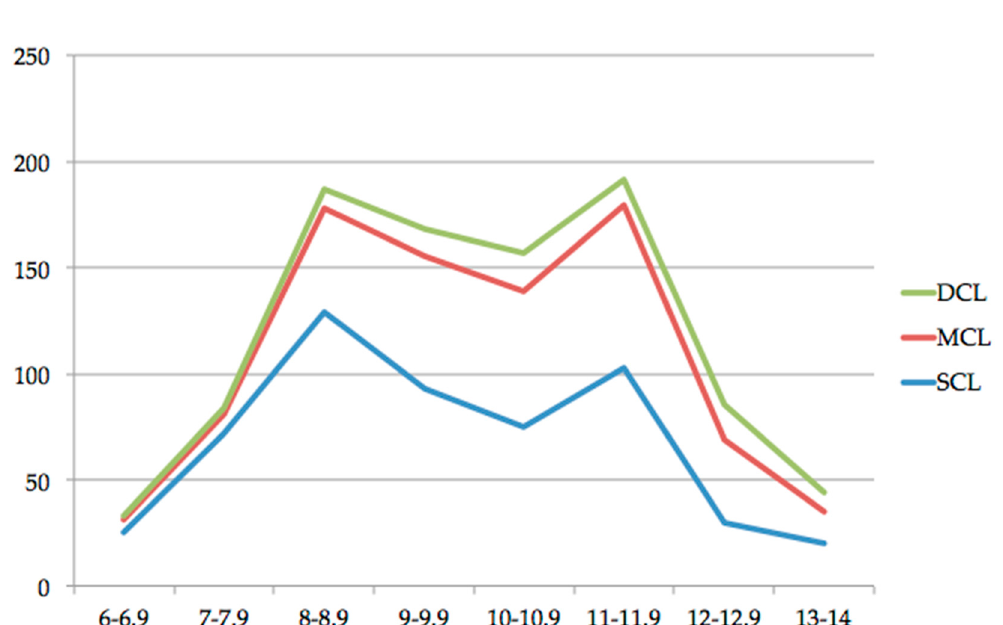
Figure 4. Distribution of superficial carious lesions (SCL), medium carious lesions (MCL), and deep carious lesions (DCL) according to the chronological age of the patients (expressed in years).